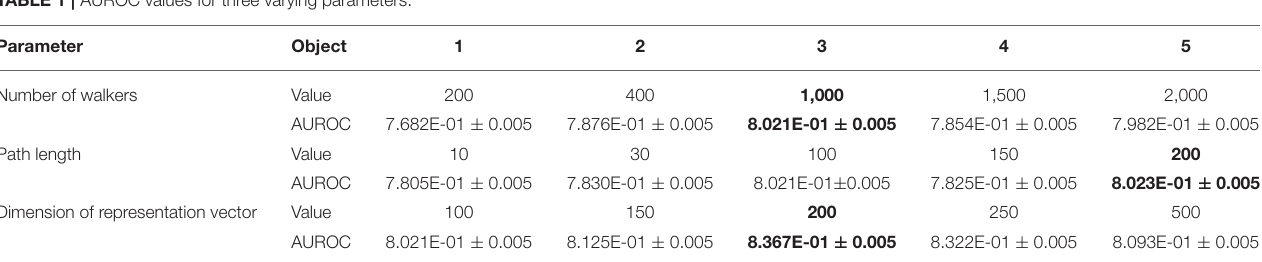
The bold values indicate the best results in the experiments with different values of parameters.